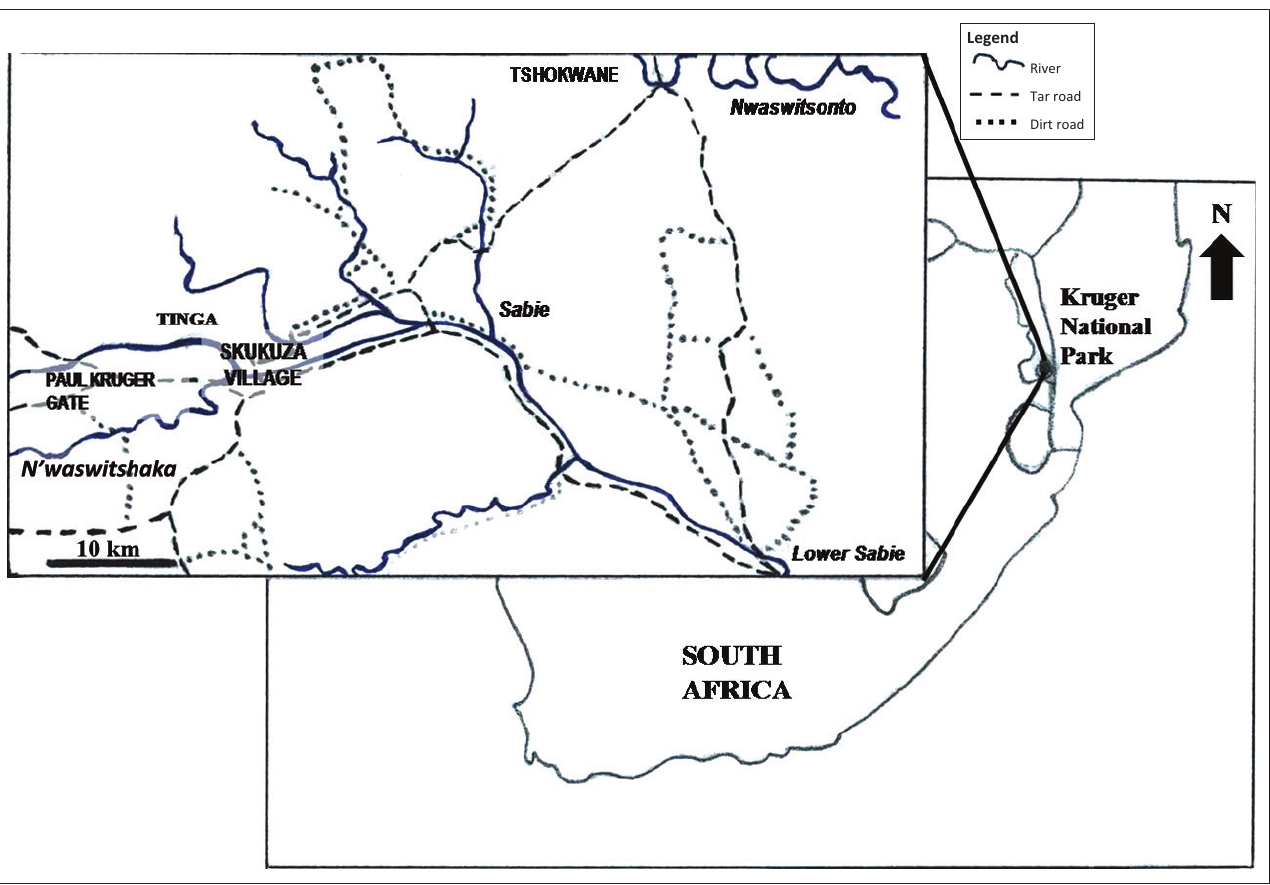
FIGURE 1: Map of Kruger National Park, showing Skukuza Village and the three rivers (N’waswitsontso, Sabie and N’waswitshaka) where sampling of Kigelia africana took